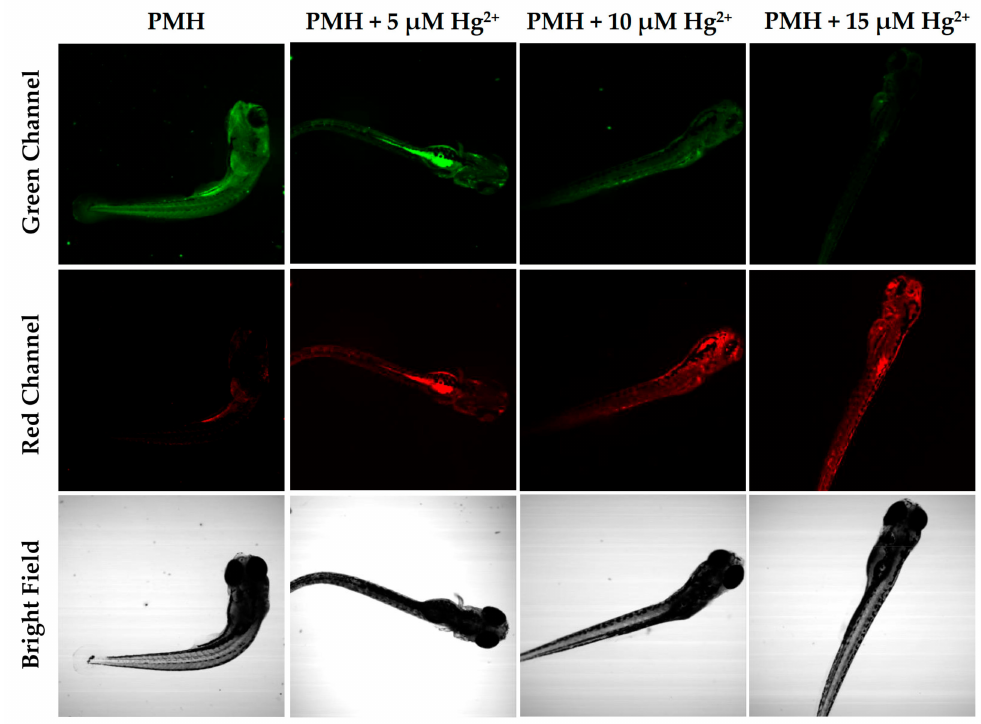
Figure 5. Confocal microscopy images of zebrafish embryos with PMH and Hg 2 + ions. Zebrafish was incubated with the PMH probe (1 µ M) and followed by di ff erent concentration of Hg 2 + ions (0 µ M, 5 µ M, 10 µ M, 15 µ M). λ ex = 405 nm, Green Channel: fluorescent image of emission between 430–460 nm; Red Chanel: fluorescent image of emission between 490–550